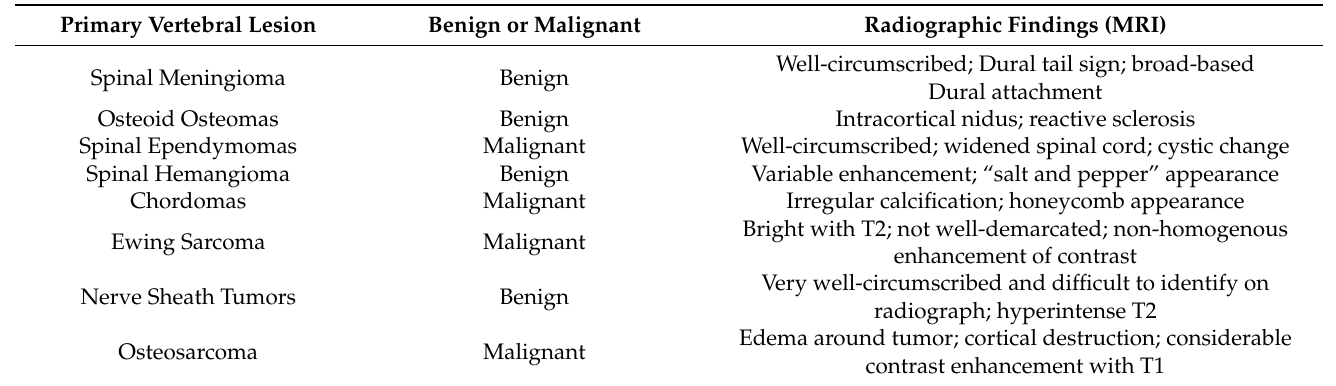
Table 1. Common primary benign and malignant vertebral lesions and their associated radiographic findings on Magnetic Resonance Imaging (MRI) [29,32].